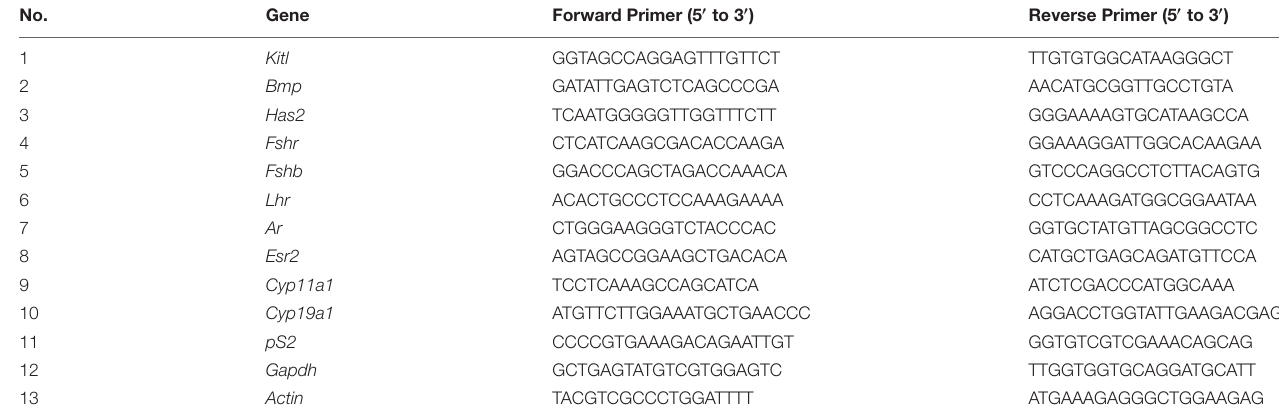
TABLE 1 | Sequence identification and primers used for RT-PCR analysis. No. Gene Forward Primer (5 (cid:48) to 3 (cid:48) ) Reverse Primer (5 (cid:48) to 3 (cid:48)